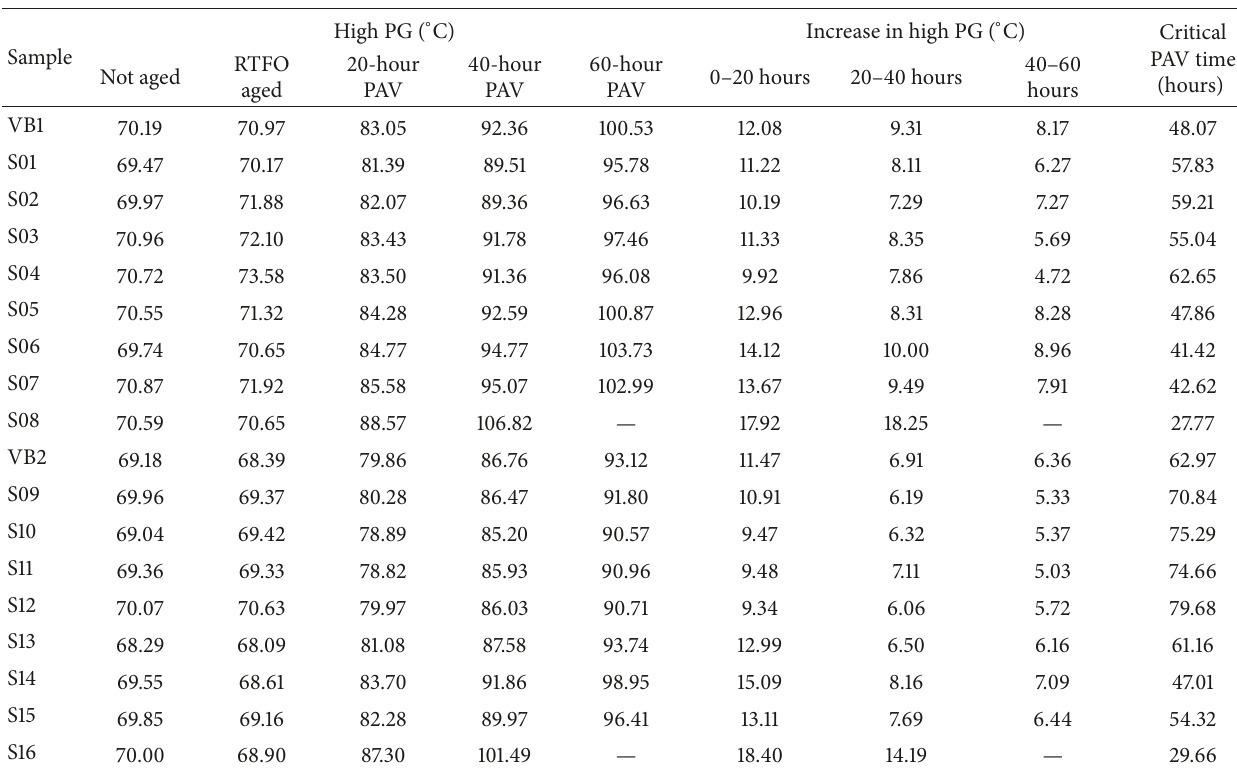
Table 5: The increase in high PG of samples after each level of aging and resulting critical PAV time.